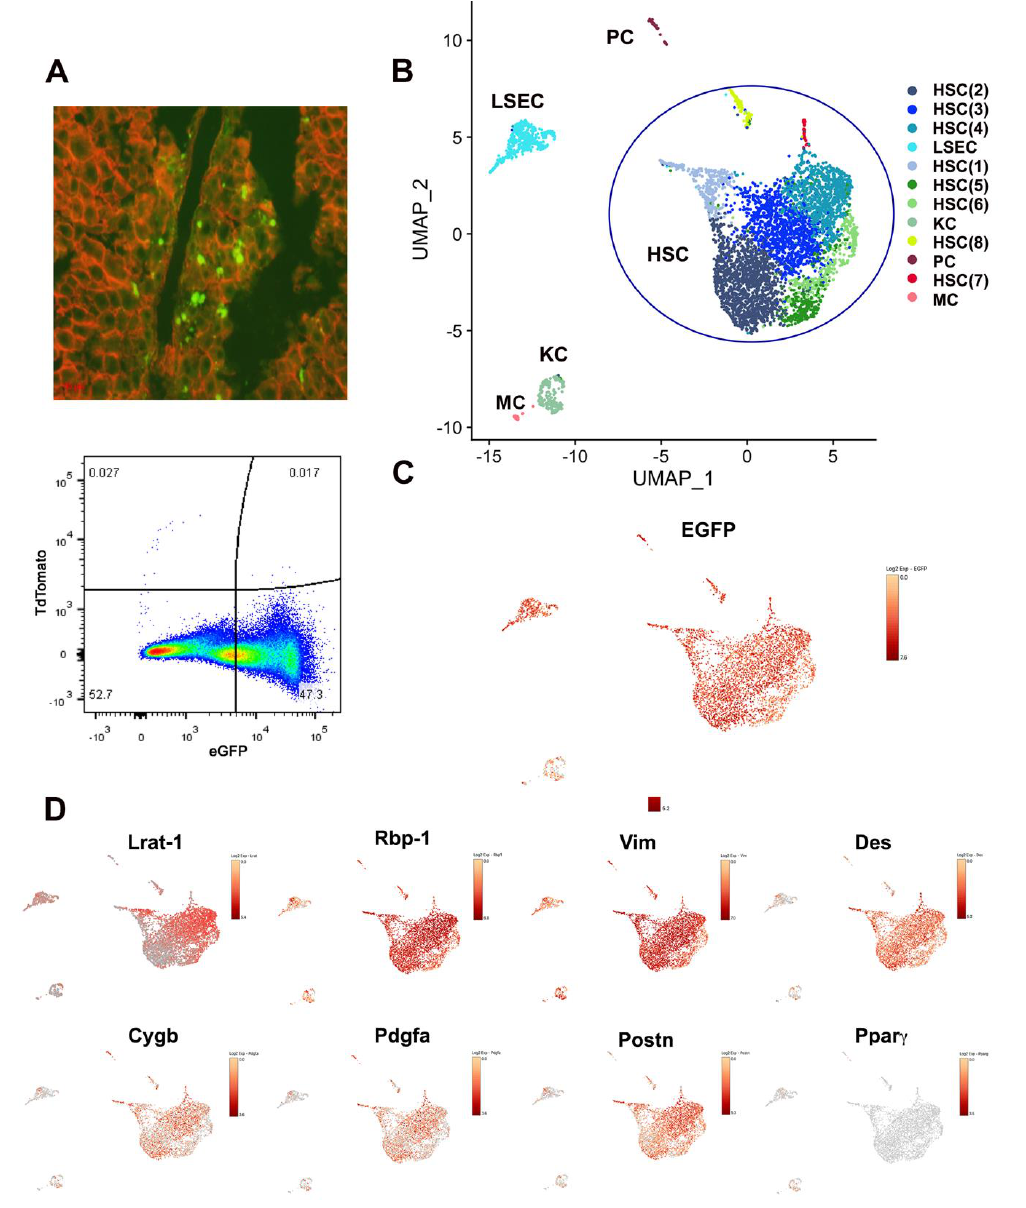
Figure 1. Single-cell RNA sequencing analysis of HSC population in CCl 4 treated mouse liver. ( A ) upper panel, a representative image of mouse liver from CCl 4 -treated LRAT-Cre:Rosa26 mT/mG dual-fluorescent reporter mouse, in which GFP positive cells shown in green fluorescence signals are Lrat -Cre traced cells in injured areas (100×); lower panel, a representative scatter FACS image of isolated GFP positive liver cells from CCl 4 -treated LRAT-Cre:Rosa26 mT/mG mouse liver. ( B ) 2D Uniform Manifold Approximation and Projection (UMAP) visualization of single-cell clustering of filtered GFP positive cells from a CCl 4 -treated reporter mouse liver. Based on the signature gene expression profile, the color-coded identity of each cell cluster is defined on the right. HSC: hepatic stellate cells (HSC 1-8); KC: Kupffer cells; LSEC: liver sinusoidal endothelial cell; MC: mononuclear cells; PC: progenitor cell. ( C ) 2D UMAP visualization of GFP expression in all filtered cells within each cell cluster. ( D ) Representative Loupe images of HSC marker genes in all clusters.